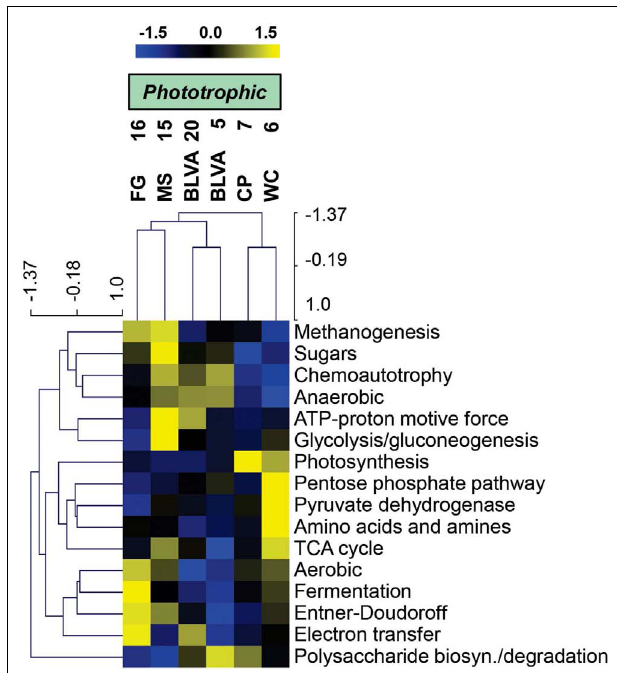
FIGURE 8 | Hierarchical cluster analysis of relative abundances of genes inTIGRFAMs associated with “Energy Metabolism” classified by functional category . Data was standardized by functional category before clustering to avoid biasing analysis by a few categories with high gene abundance. Pearson correlation was used as the distance measure for average linkage agglomerative